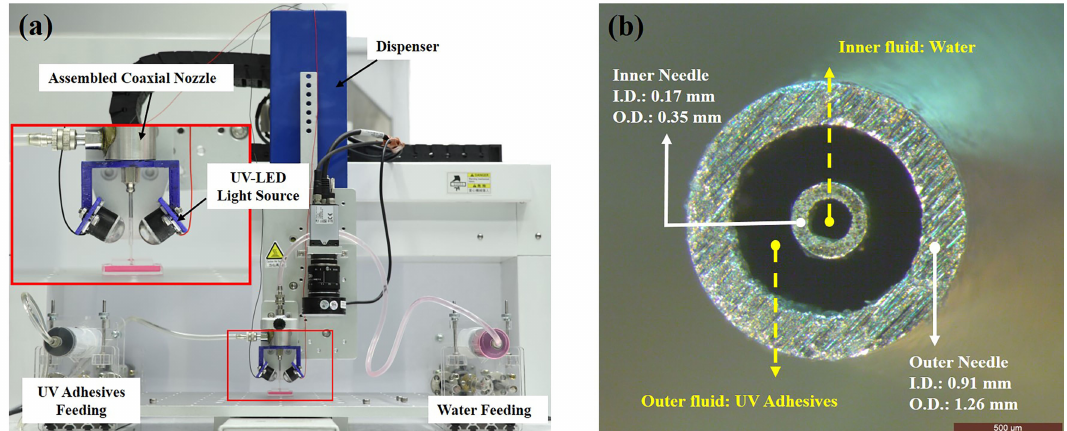
Figure 1. Experimental setup: ( a ) the total UV-assisted coaxial 3D printing system consisted of a commercial dispenser, an assembled coaxial nozzle, a UV-LED light source, and two syringe drivers for fluids feeding; and ( b ) bottom view of the assembled coaxial nozzle without the transparent jacket where the outer needle (ID 0.91 mm, OD 1.26 mm) for UV adhesives and the inner needle (ID 0.17 mm, OD 0.35 mm) for